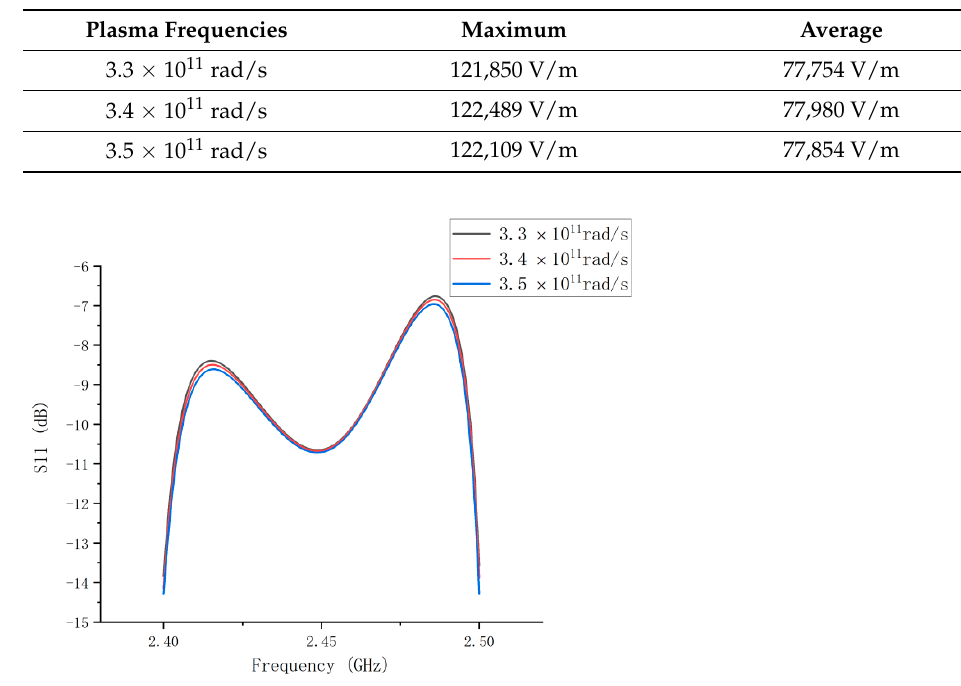
Figure 10. Comparison of S11 with different plasma frequencies.